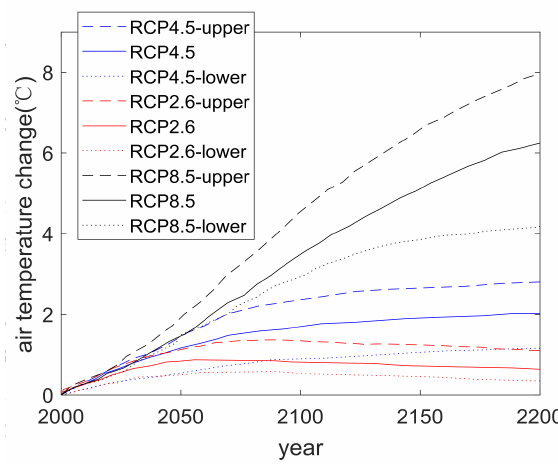
Figure 7. Global averaged temperature